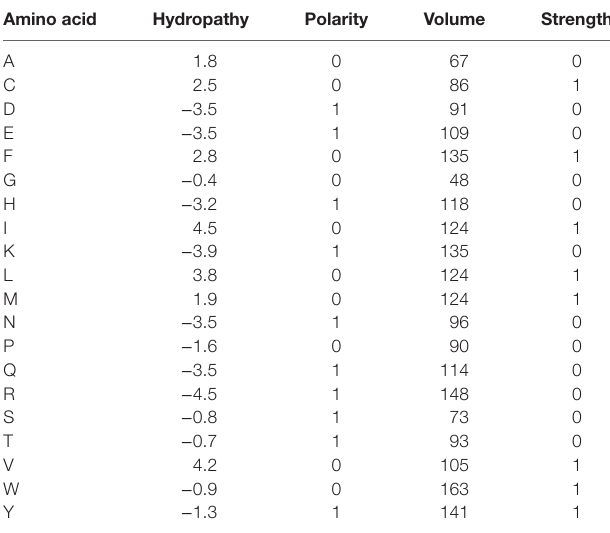
Table 1 | Values used for CDR3 amino acid properties calculation by VDJtools. amino acid